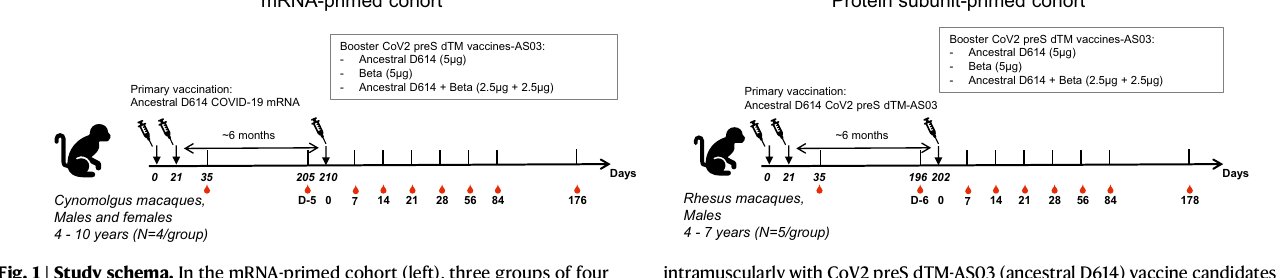
intramuscularly with CoV2 preS dTM-AS03 (ancestral D614) vaccine candidates on D0 and D21. Both cohorts were boosted 7 months post-dose 1 with monovalent (ancestral or Beta) or bivalent (ancestral+Beta) CoV2 preS dTM-AS03. Humoral immune responses were assessed up to 6 months